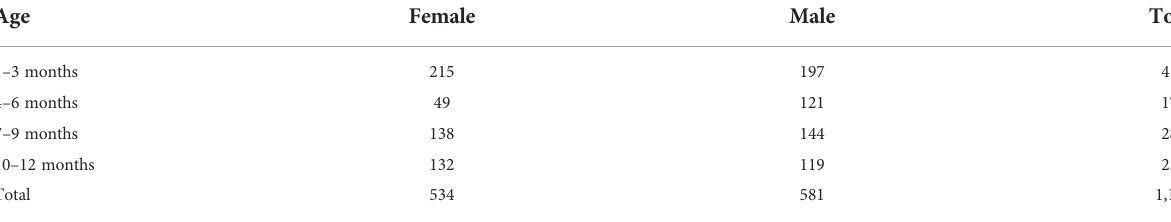
TABLE 1 Sample sizes of spotted seal pup vocalizations for different sex and age groups.